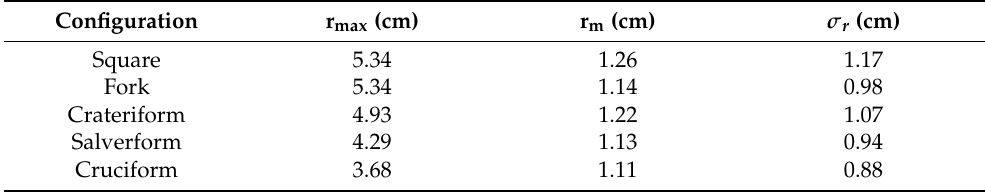
Table 1. Characteristic values of the geometrical analysis of the different